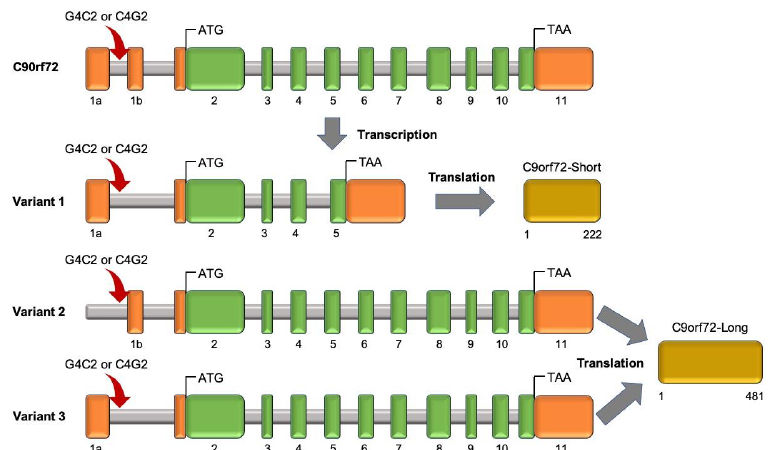
Figure 7. C9orf72 gene structure, transcript variants, and protein isoforms. The C9orf72 gene consists of 11 coding exons (green) and non-coding exons (orange). The G4C2 or C4G2 HRE is located in the first intron of variants 1 and 3 and within the promoter region of variant 2. This figure was adapted from Balendra and Isaacs’s study